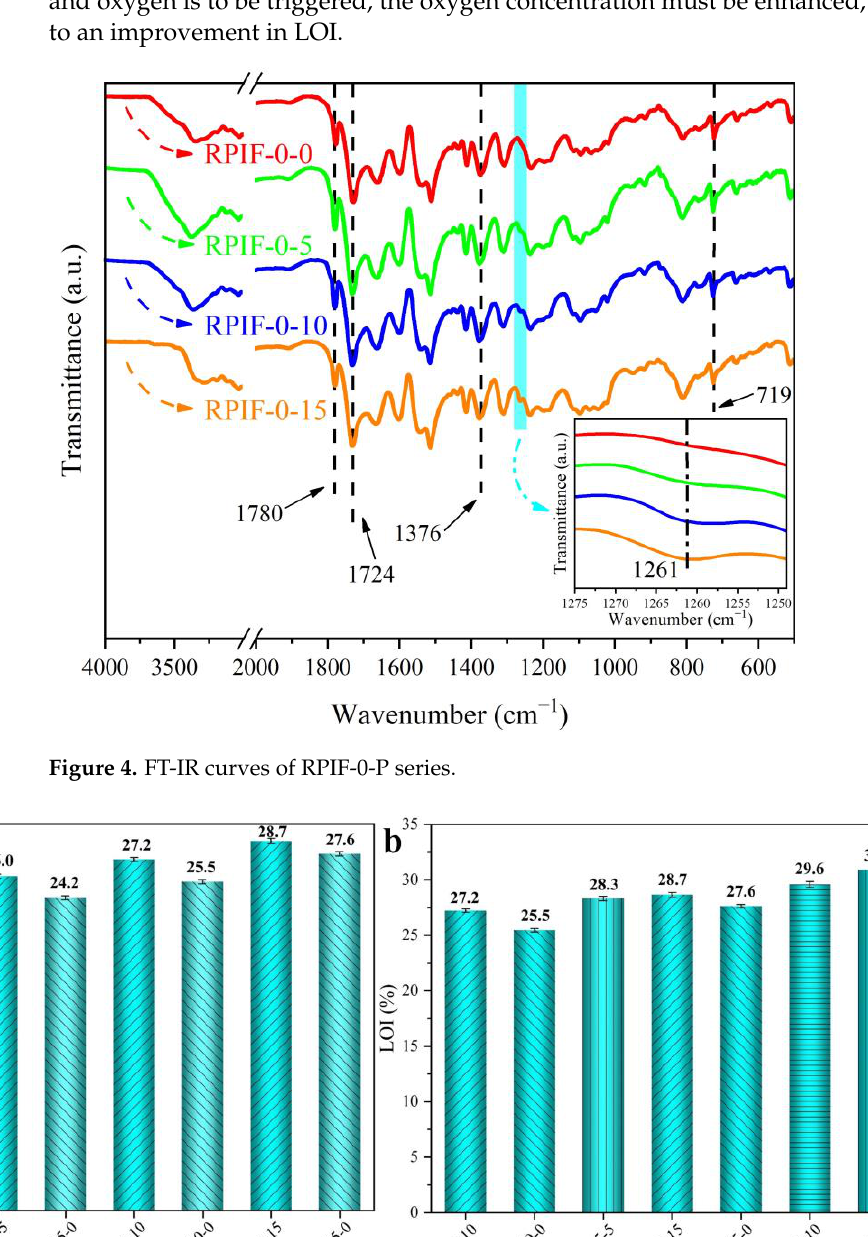
Figure 3. EDS results of RPIF-0-0 ( a , a′ ) and RPIF-0-10 ( b , b′ ).